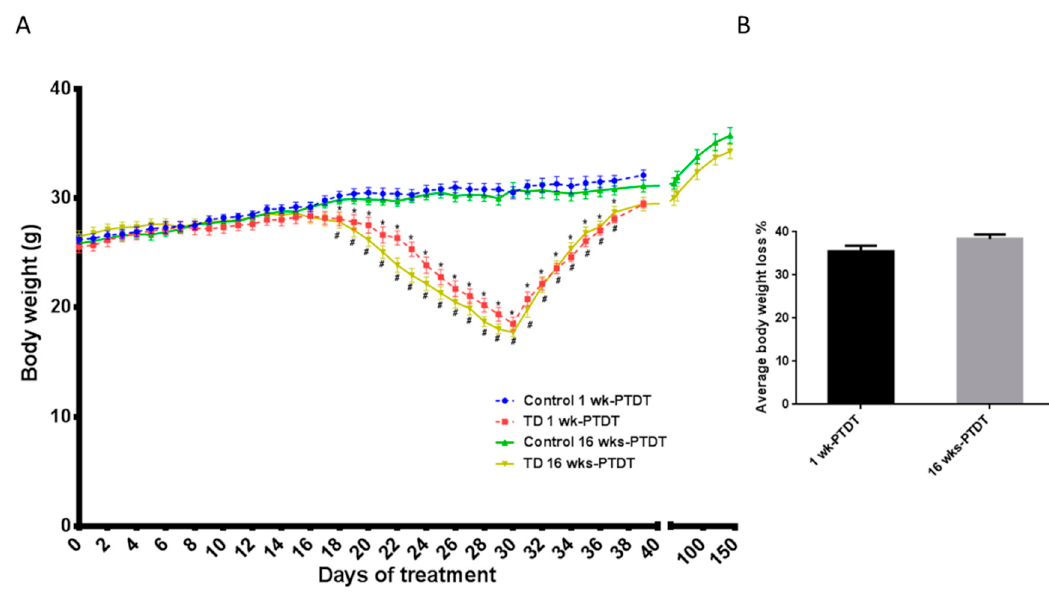
Figure 2. The effects of thiamine deficiency (TD) on body weight. The body weight profiles of animals in each group in the two cohorts were recorded ( A ), and the maximal body weight loss during TD treatment was calculated as the ratio between the body weight loss on the 30th day of TD treatment and the maximal body weight the animal achieved, which occurred mostly at around the 14th day of TD treatment ( B ). * p < 0.05 denotes a statistically significant difference from the control group in the 1 wk-PTDT cohort; # p < 0.05 denotes a statistically significant difference from the control group in the 16 wks-PTDT cohort. For the 1 wk-PTDT cohort, n = 10 for both control and TD groups. For the 16 wks-PTDT cohort, n = 10 for the control group, and n = 9 for the TD group.